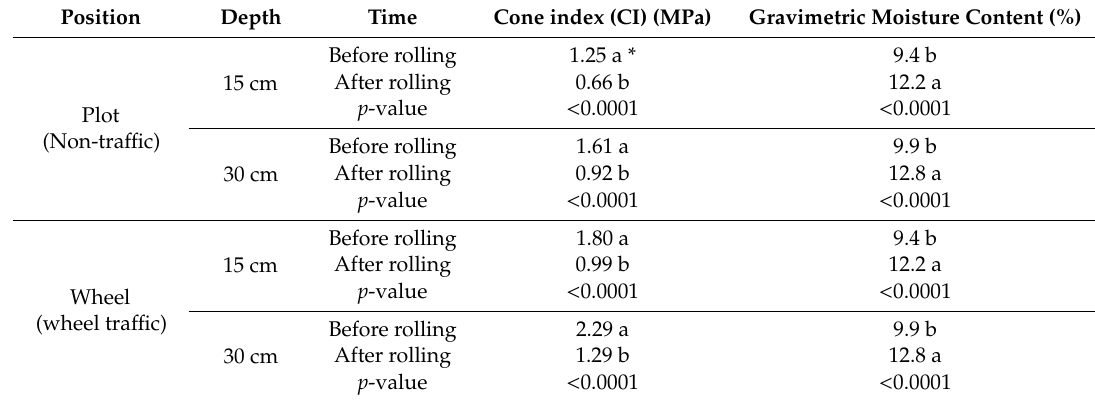
Table 9. CI values averaged over two depths (0–15 cm and 15–30 cm) and corresponding gravimetric soil moisture content in 2017 growing season.